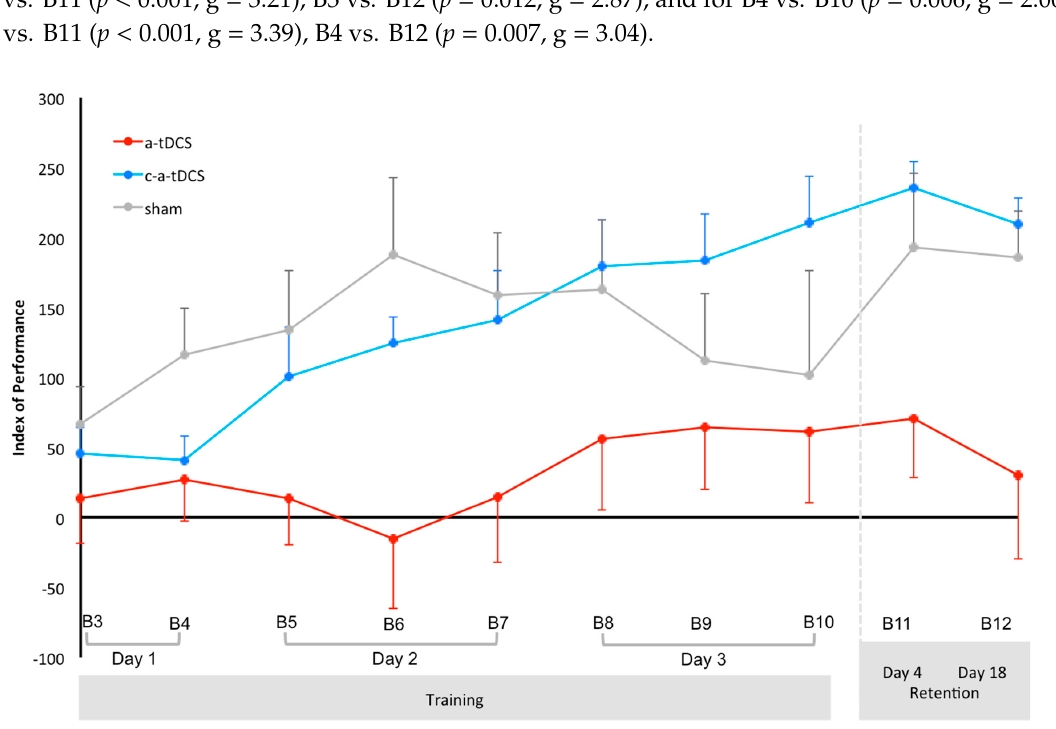
Figure 3. Evolution of the mean (and one SEM) index of performance over time (blocks—B) for each of the 3 groups. B3, B6 and B9 represent online tDCS. B4, B7 and B10 represent immediate offline. B5 and B8 represent delayed offline.